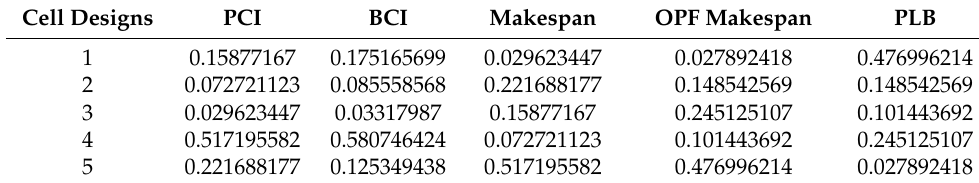
Figure 7. Obtained values of pairwise comparison matrices for Cell Designs 1–5. Table 4. Obtained priority vectors values for all the criteria.